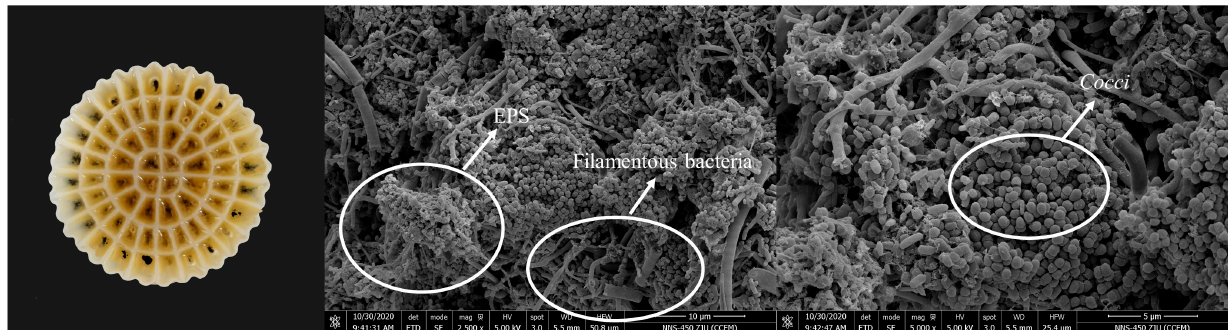
Figure 2. Morphology of the biofilm on biocarriers.